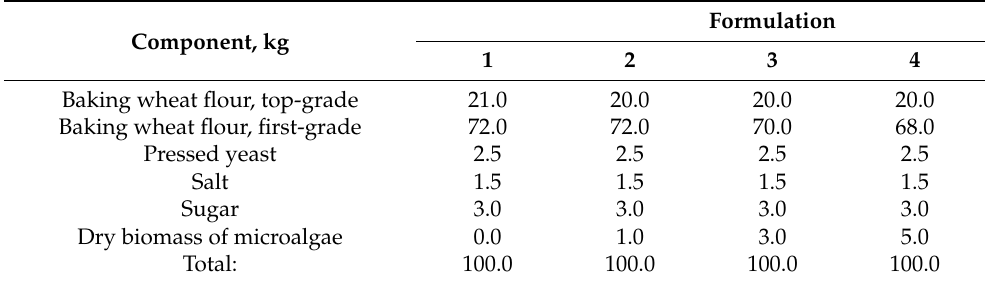
Table 4. The formulation of wheat flour bread with